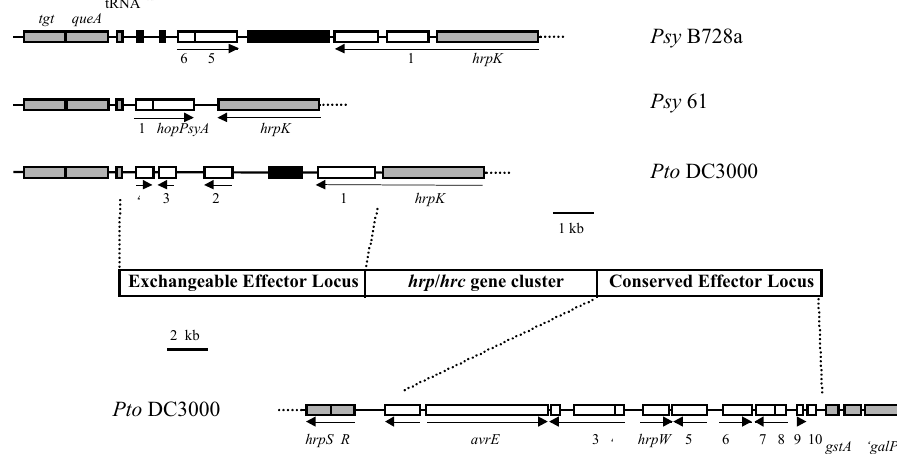
Fig. 2. The tripartite mosaic structure of the Hrp pathogenicity island. The hrp / hrc cluster contains structural and regulatory genes for the assembly of a type III secretion apparatus, most of which are highly conserved among different P. syringae strains. The Exchangeable Effector Locus (or EEL) from P. syringae pv. syringae B728a (7.3 kb) and 61 (2.5 kb) and from P. syringae pv. tomato DC3000 (5.9 kb) are shown; they are all flanked by tgt - queA -tRNA leu and hrpK sequences, shown only for strain B728a and denoted by grey boxes. White boxes with numbers indicate open reading frames, which are not conserved between EELs, in spite of identical numbering. Black boxes denote mobile genetic elements. The Conserved Effector Locus (approx. 17 kb) from DC3000 is shown, with bordering genes shown as grey boxes. White boxes denote ORFs (shown with numbers) or previously described genes that belong to the CEL. In all cases, arrows indicate transcriptional units that start with a “ hrp box”. Modified from Alfano et al. (2000) and Collmer et al.